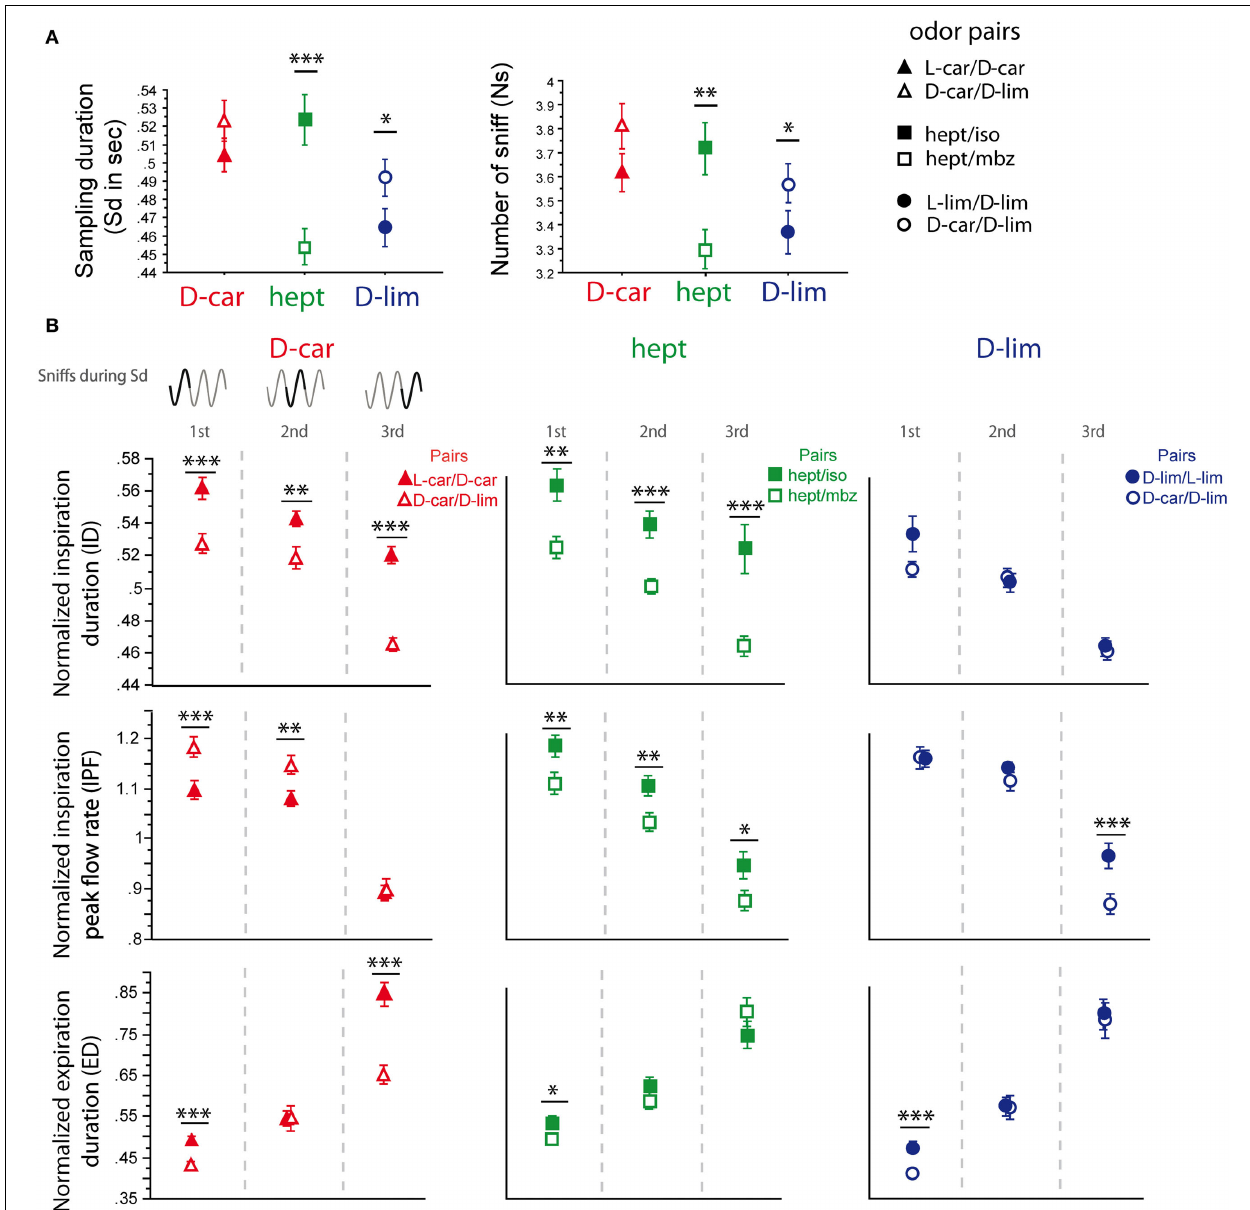
FIGURE 6 | Sniffing variations depend on the pair in which an odorant is presented. (A) Global sampling parameters (mean ± s.e.m.), Sd (left), and Ns (right), for each odorant depending on the pair in which it was presented. D-car (red, n = 206) in the D-car/L-car pair (filled triangle) and in the D-car/D-lim pair (empty triangle); hept (green, n = 155) in the hept/iso pair (filled square) and the hept/mbz (empty square); D-lim (dark blue, n = 206) in the D-lim/L-lim pair (filled circle) and the D-car/D-lim pair (empty circle). (B) Modulation of respiratory parameters in the first, second, and third cycles for